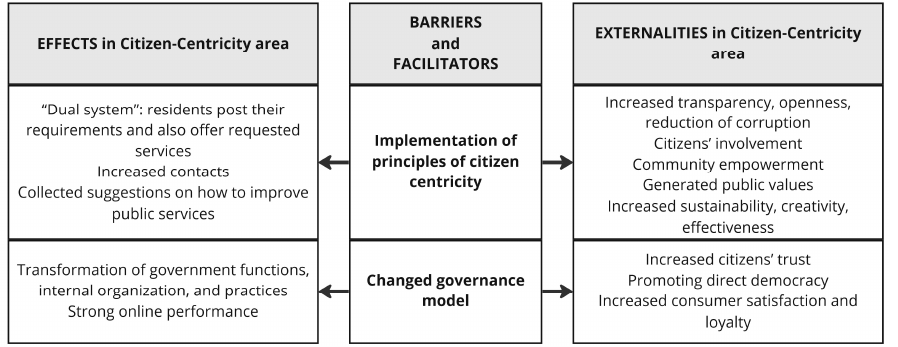
Figure 5. Barriers or facilitators, effects, and externalities of smart governance implementation in the Citizen-Centricity area. Source: generated by the authors.